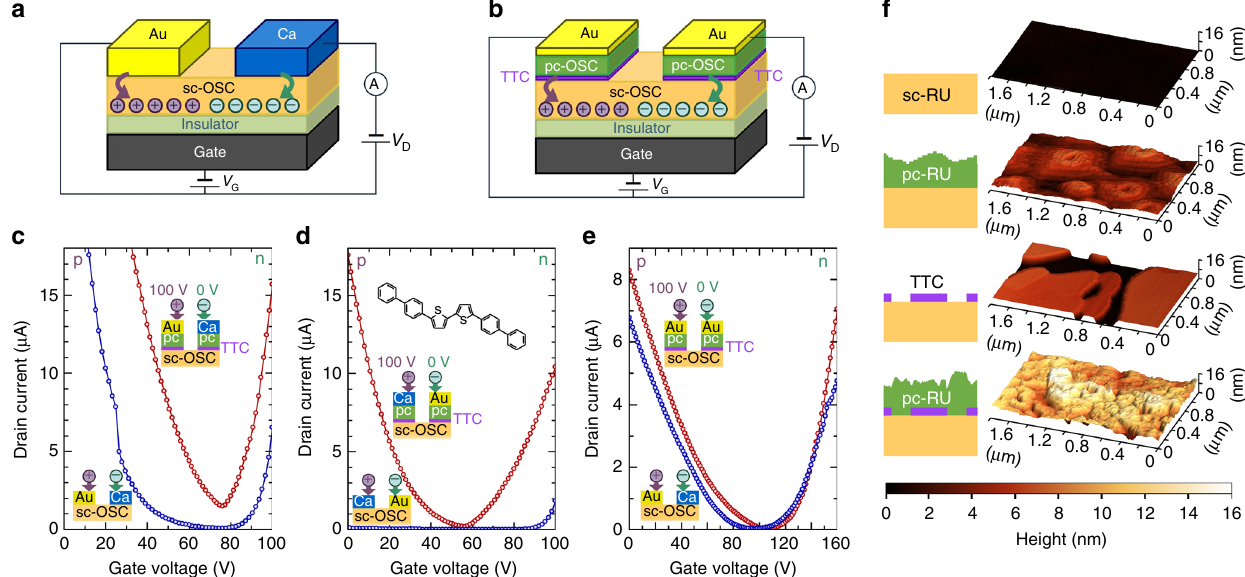
Fig. 1 Carrier injection performance of conventional and novel electrodes. a A fi eld-effect transistor (FET) with Au and Ca electrodes for holes and electrons injection, respectively. b A FET with the new electrodes Au/pc-OSC/TTC both for electrons and holes. Carrier injection performance for sc-BP2T FET with hetero electrodes; c Au for holes and Ca for electrons (blue circles) vs. Au/pc-BP2T/TTC for holes and Ca/pc-BP2T/TTC for electrons (red circles), d Au for electrons and Ca for holes (blue circles) vs. Au/pc-BP2T/TTC for electrons and Ca/pc-BP2T/TTC for holes (red circles), e Au for holes and Ca for electrons (blue circles) vs. Au/pc-BP2T/TTC for both holes and electrons (red circles). f Surface morphology of sc-RU, pc-RU/sc-RU, TTC/sc-RU, and pc- RU/TTC/sc-RU, respectively, measured with an atomic force